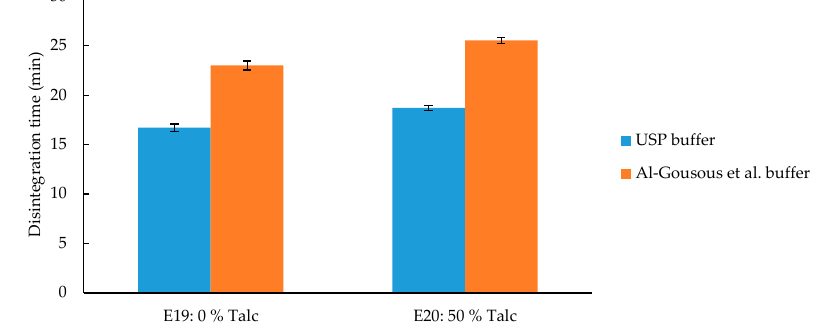
Figure 8. Disintegration time of C-A-P formulations with different talc content. Given are average disintegration times ± SD; n = 6. Talc content is based on dry polymer weight.